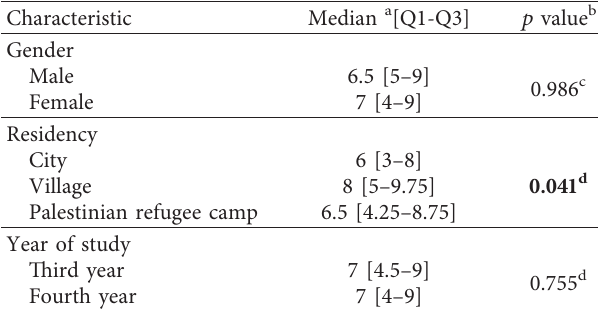
Table 13: Association between nursing students’ demographic characteristics and first aid score.